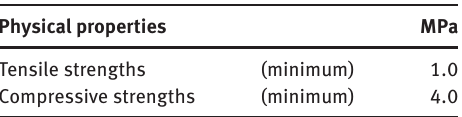
Table 6 According to TS25 expected from the physical properties of natural